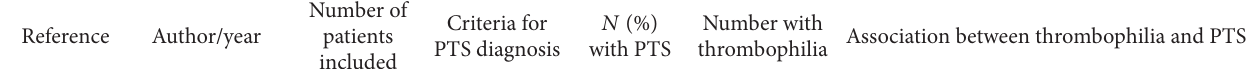
Table 2: Included studies in chronic venous ulcer